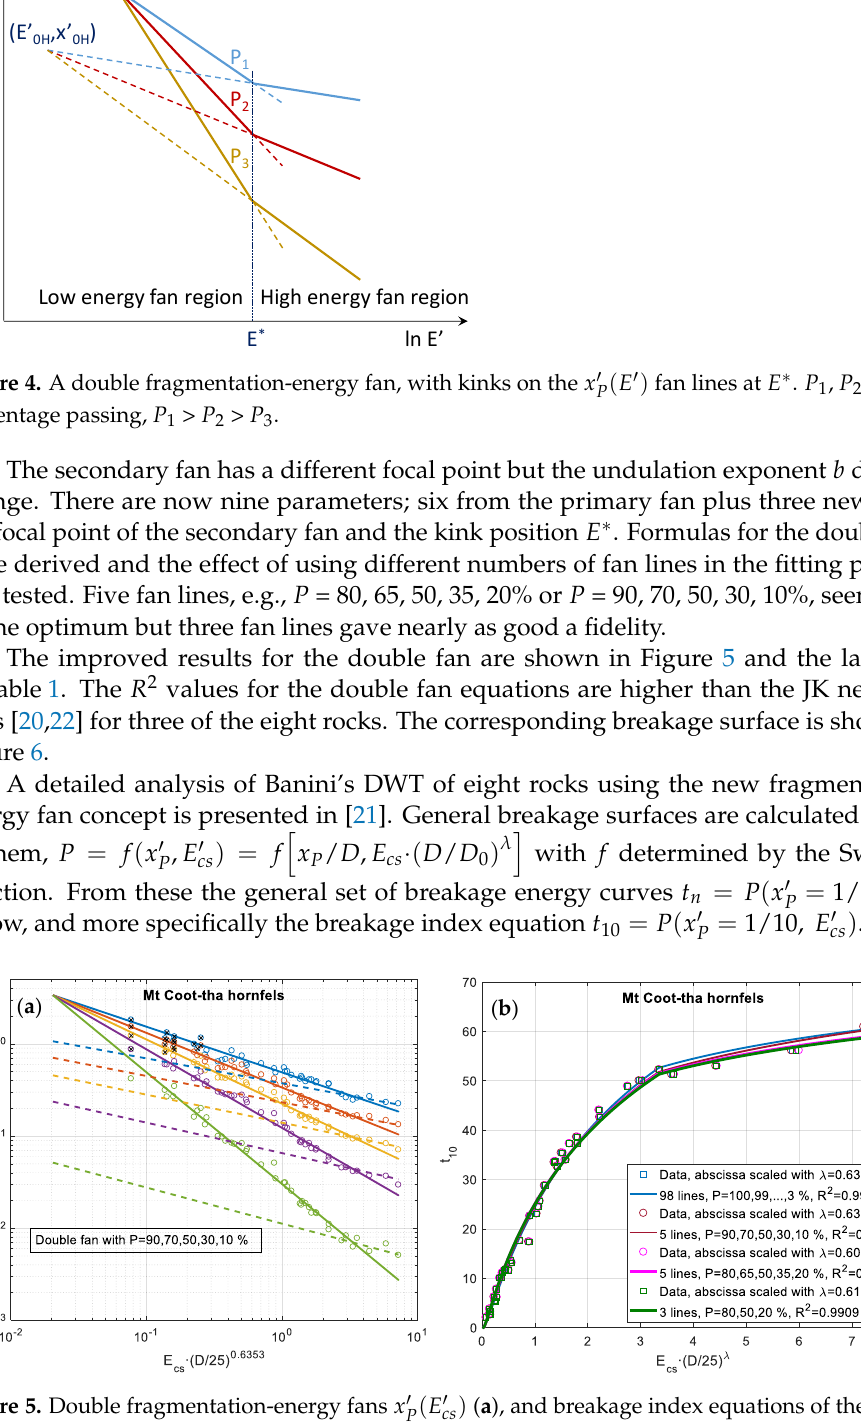
Figure 5. Double fragmentation-energy fans 𝑥 𝑃′ (𝐸 𝑐𝑠′ ) ( a ), and breakage index equations of the scaled impact energy 𝑡 10 (𝐸 𝑐𝑠′ ) ( b ) for Mt Coot-tha hornfels. Circles are data points. Solid and dashed lines in ( a ) are primary and secondary fans, respectively ([21], Figure 14). Colors indicate different per- centiles: blue — 90 %, red — 70 %, yellow — 50 %, purple — 30 %, green — 10 %.